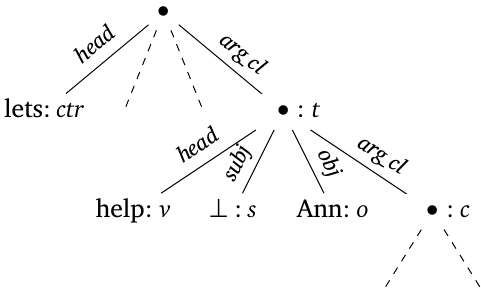
Instantiation of the logical constraints for the second occurrence of p 1